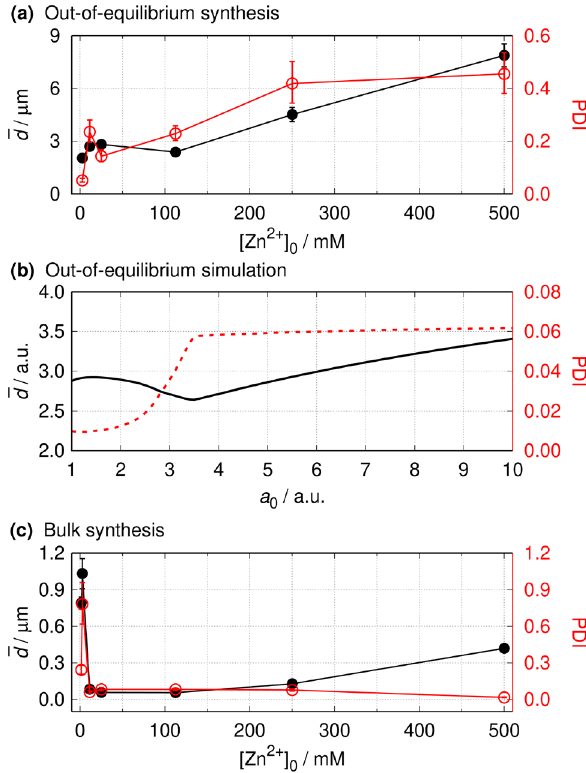
Figure 3. Concentration dependence of the average size and polydispersity in the middle of the precipitate zone in the reaction–diffusion synthesis in experiments ( a ) and simulations ( b ), and in case of the equilibrium bulk synthesis with fast mixing ( c ). The experimental conditions are the same as in Fig. 2. The error bars represent the 95% confidence interval of the measured data. The total length of the simulation was t synt =